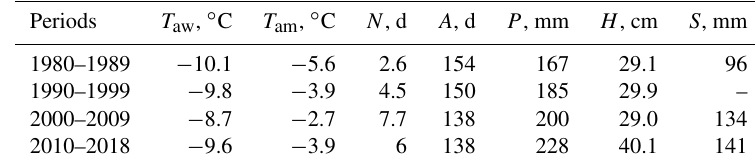
Table 1. Some climatic characteristics for the study region T aw – the mean long-term air temperature for the winter period (December to February), T am – the mean long-term air temperature for March, N – the number of days in the winter period with daily temperatures above 0 ◦ C, A – the duration of the cold period (the number of days with a stable average daily temperature below zero), P – the mean long-term precipitation for the cold period, H – the mean long-term snow depth for the winter period, S – the average long-term water storage in the snow for the first decade of March.